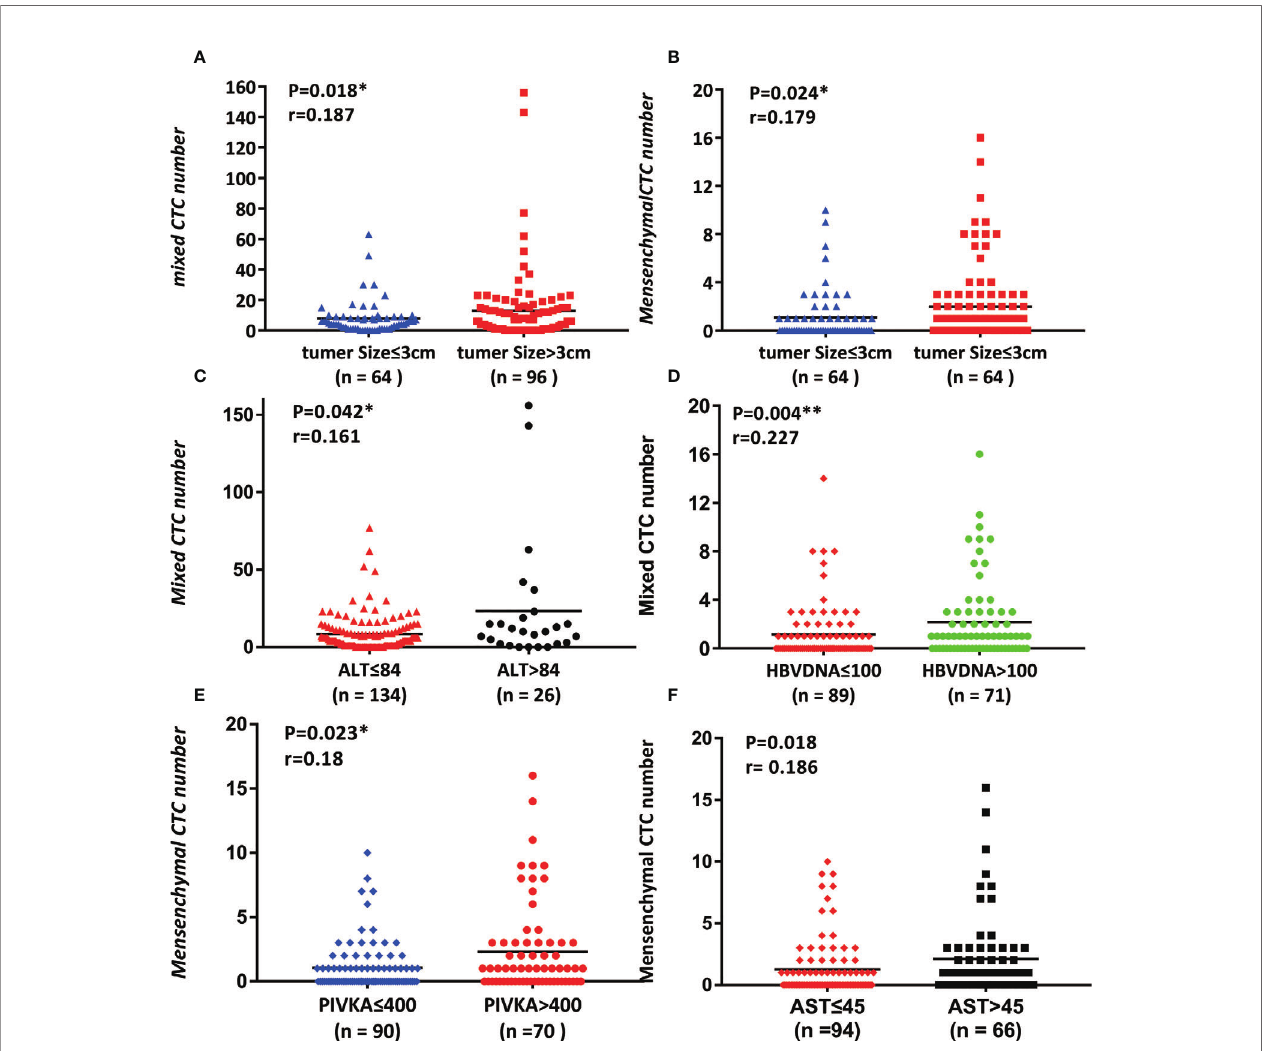
FIGURE 2 | Association of CTC counts and subtypes with early clinical characteristics. (A, B) Tumor size was connected with the number of mixed CTCs and the number of mesenchymal CTCs, p<0.05; (C, D) alanine transaminase (ALT) and HBV DNA were correlated with the mixed CTC number, p<0.05; (E, F) PIVKA and aspartate amino transferase (AST) are related to mesenchymal CTC number,